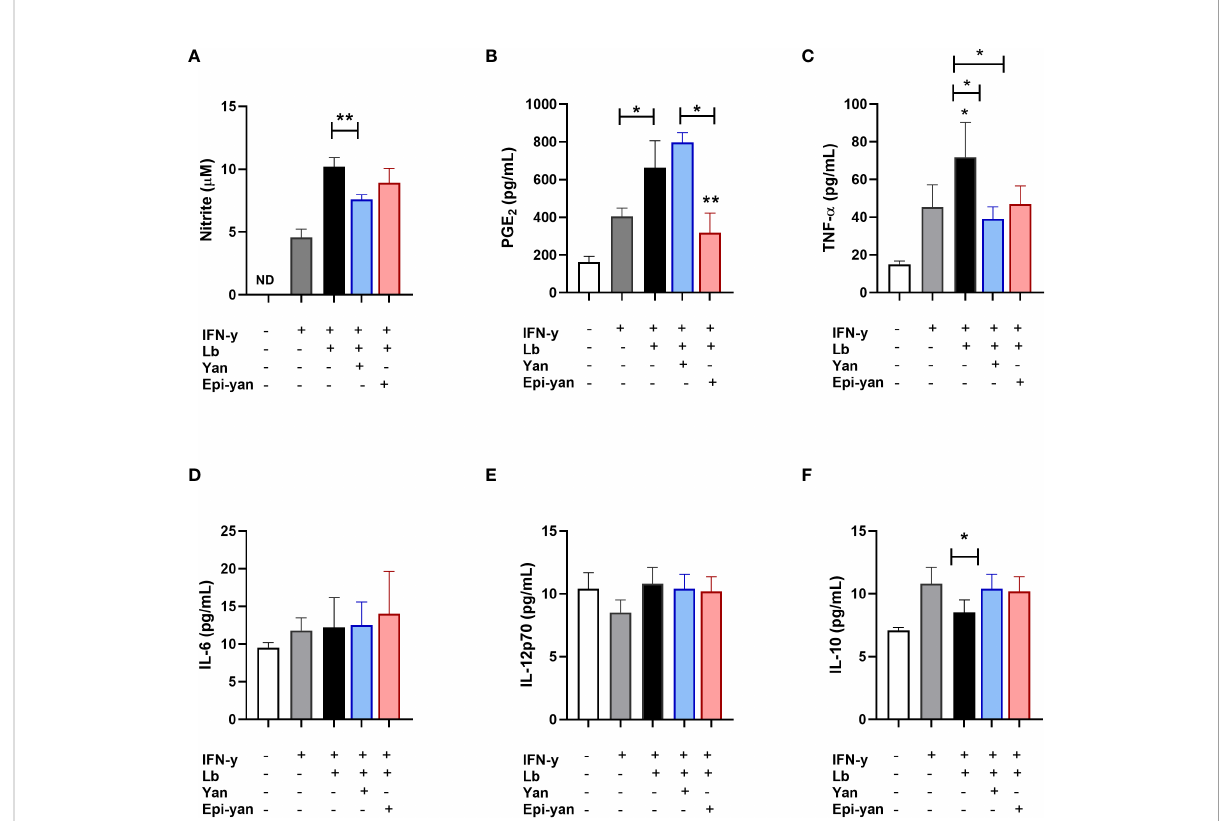
FIGURE 5 Immunomodulatory effects of yangambin and epi-yangambin on L. braziliensis -infected macrophages. Mediators were analyzed in the supernatants of cultured BMDM previously stimulated with IFN- g , then infected with L. braziliensis and fi nally treated with yangambin or epi- yangambi (100 µM) for 48h, as described in Materials and Methods . (A) Nitrite, (B) PGE2, (C) TNF- a , (D) IL-6, (E) IL-12p70 and (F) IL-10. Bars represent ±SD of a single experiment performed in quintuplicate. The Kruskal-Wallis test, followed by Dunn's post-test, was used for multiple comparisons, while the Mann-Whitney test was used for comparisons between two groups (*p < 0.05 and **p < 0.01). Lb, Leishmania braziliensis ; Yan, yangambin; Epi-yan, epi-yangambin.